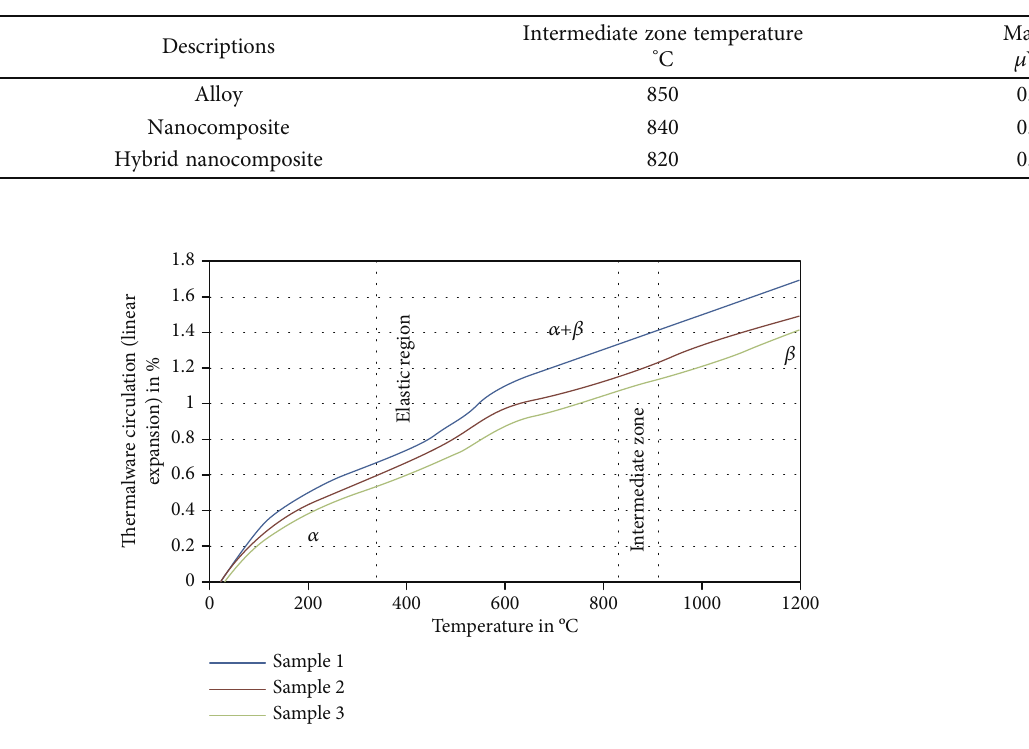
Figure 3: Thermal wave circulation (linear expansion and adsorption) phase transformation of silver matrix hybrid nanocomposite.